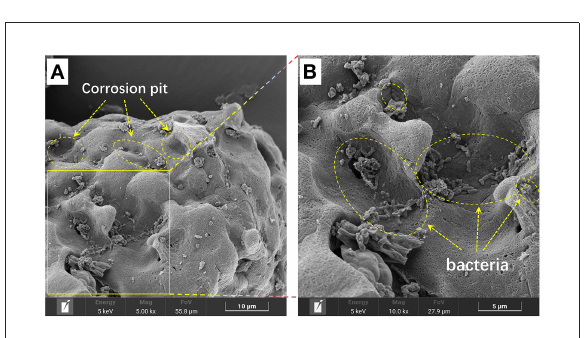
FIGURE9 SEM image of the bio-oxidized residue, where (B) represents the enlarged area that is delineated in (A) .